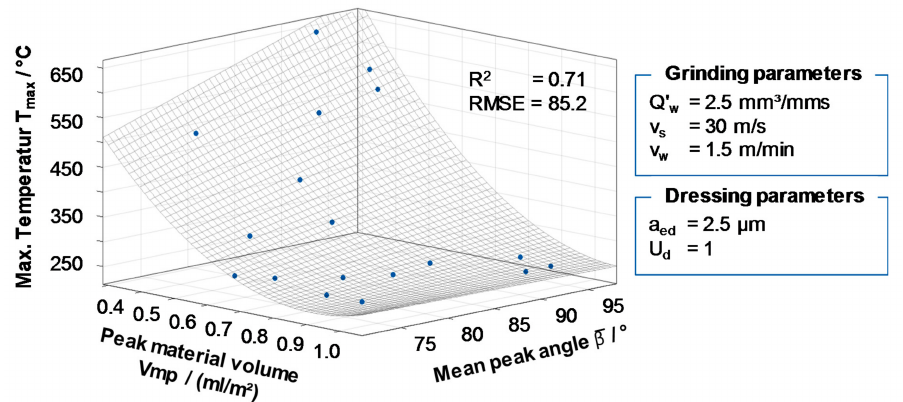
Figure 13. Grinding temperature depending on the topography parameters peak material volume and mean peak angle.